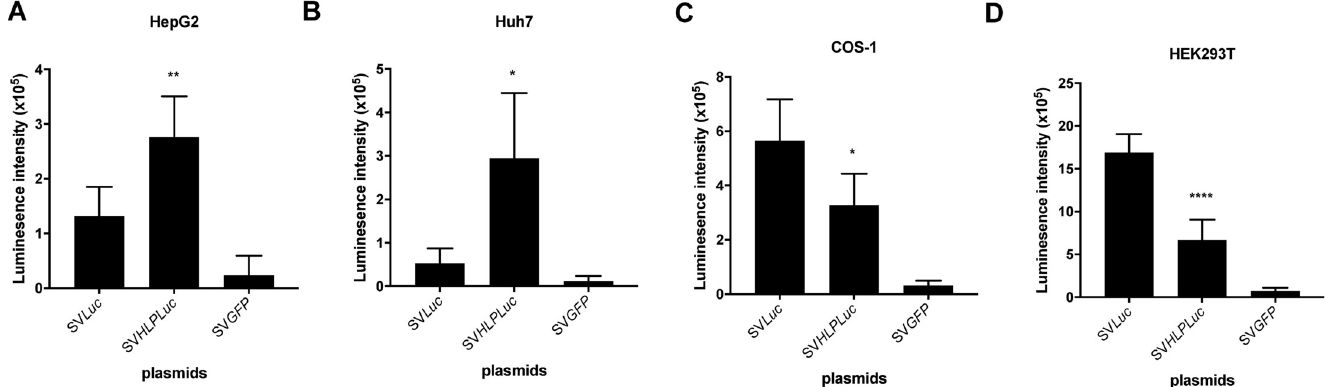
Fig 1. Insertion of a liver-specific promoter in rSV40- Luc plasmid enhances specific expression. HepG2 (A), Huh7 (B), COS-1 (C), or HEK293T (D) cells were transfected with 40 ng plasmid/10 4 cells in a well of a 96 well plate, of rSV- Luc , rSV-HLP- Luc or rSV- GFP , respectively in 6 fold. 48 hours after transfection, luciferase expression was quantified by determining the luminescence intensity. � p < 0.05, �� p < 0.01, ���� p < 0.0001. Data represent the mean ± SD. Statistical significance was determined by One-way ANOVA test.